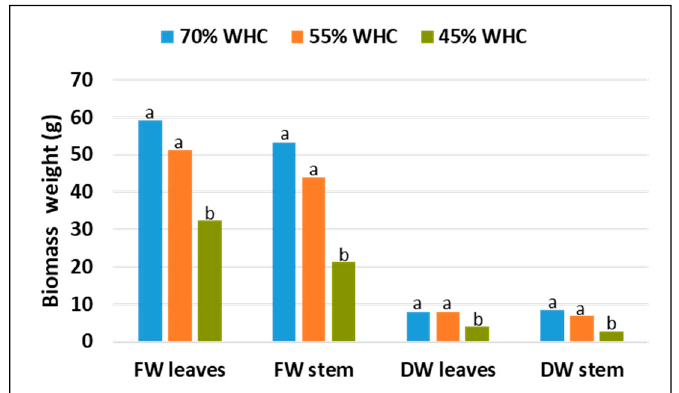
Figure 2. Effect of water stress on the fresh (FW) and dry (DW) weights of castor plants (ANOVA, Duncan test, p < 0.05, n = 5).